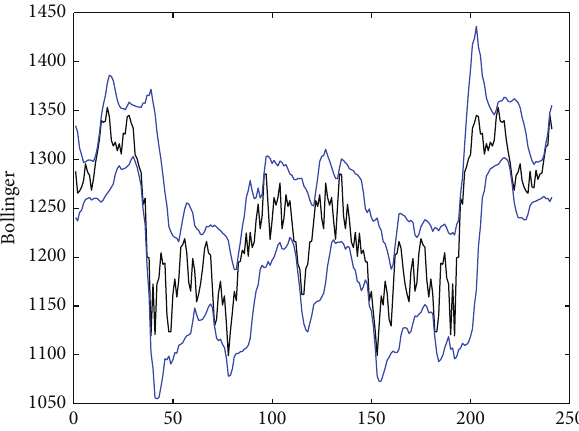
Figure 1: S&P500 annual Bollinger bands until March 27,